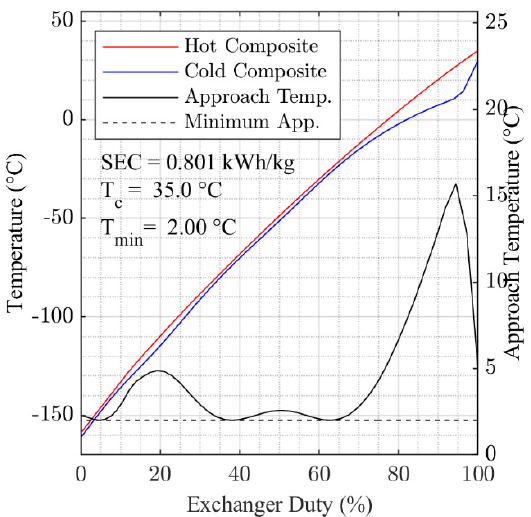
Figure A7. Optimized composite cooling curves for 35 ◦ C cooling temperature.